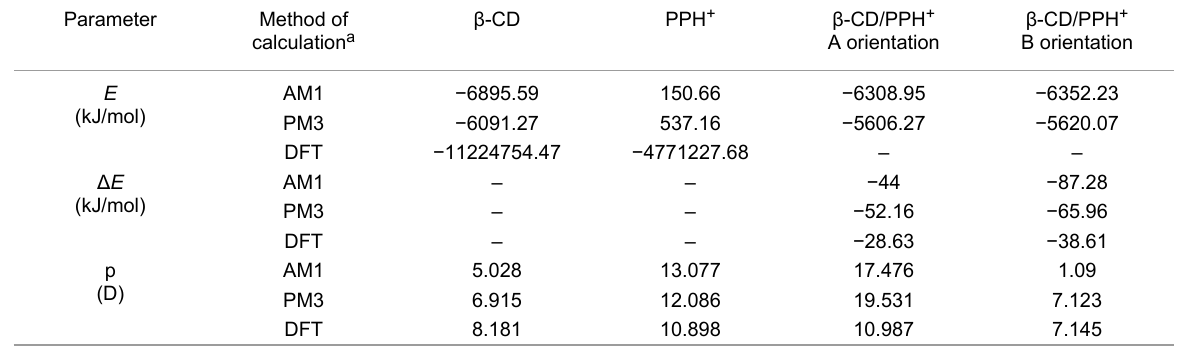
Table 3: Molecular parameters of the most stable β -CD/PPH + inclusion compounds in both A and B configuration, as given by AM1 and PM3 calcula- tions and by B3LYP/6-31G(d)+ single-point calculations applied on the PM3 optimized geometries.